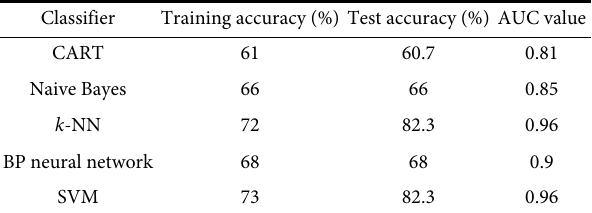
Fig. 8 Confusion matrix and ROC curve of SVM Table 4 Comparison of the classifier classification performance.